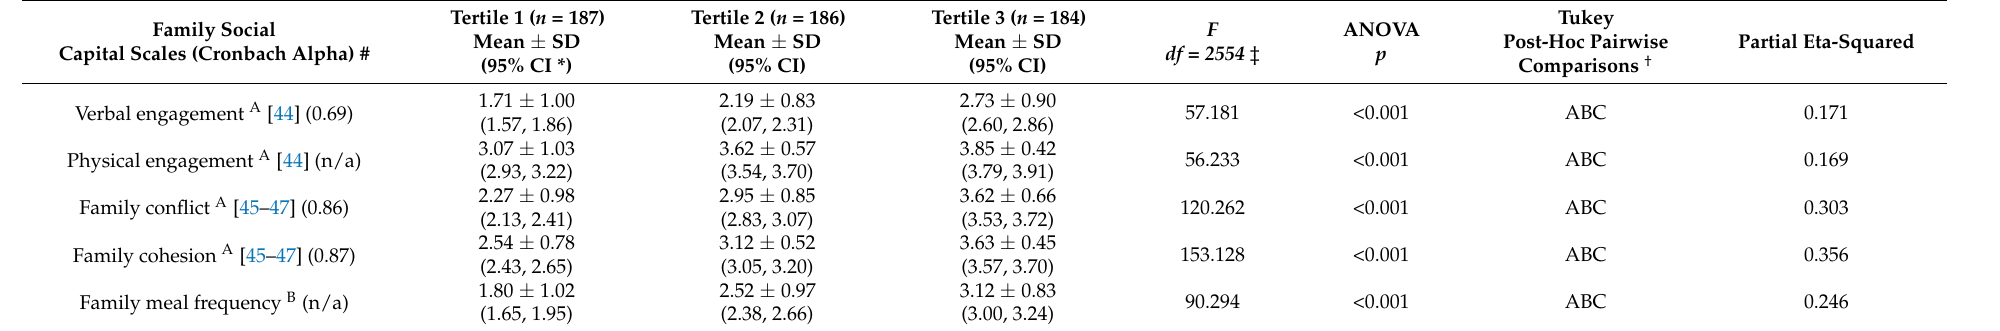
Table 1. Family social capital scale comparison by tertile ( n = 557).